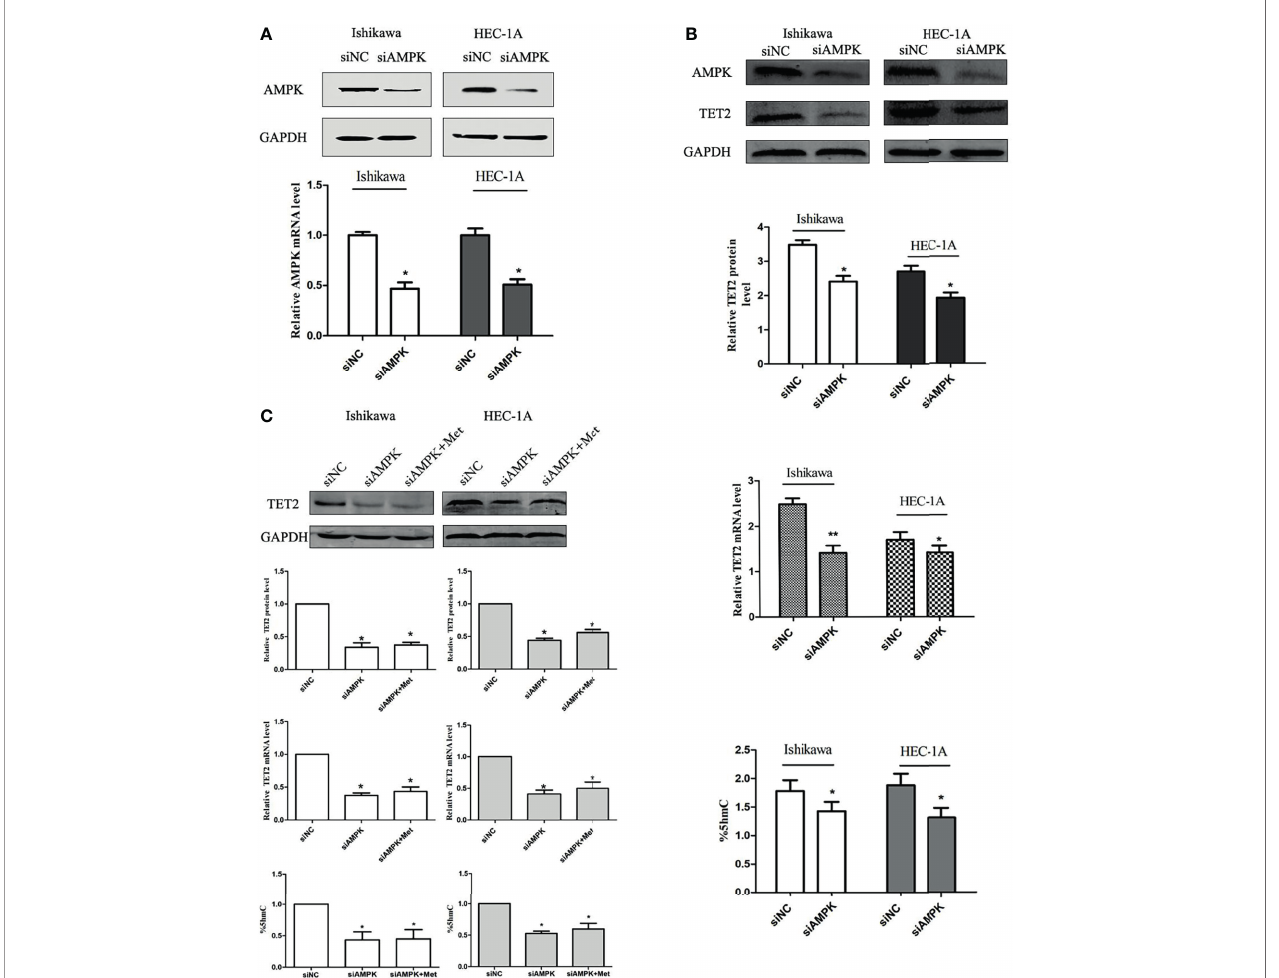
FIGURE 6 | The regulation of TET2 and 5hmC by metformin depends on the presence of AMPK. We knocked down AMPK using an siRNA. The AMPK knockdown ef fi ciency of the gene-speci fi c siRNA was con fi rmed using western blotting and real-time PCR (A) . The knockdown of AMPK gene expression with the siRNA signi fi cantly reduced the expression of TET2 and the level of 5hmC (B) . Western blotting and real-time PCR results showed that metformin did not signi fi cantly increase the expression of TET2 and 5hmC in these cells when knocked down AMPK (C) . *P < 0.05, **P < 0.01, compared with